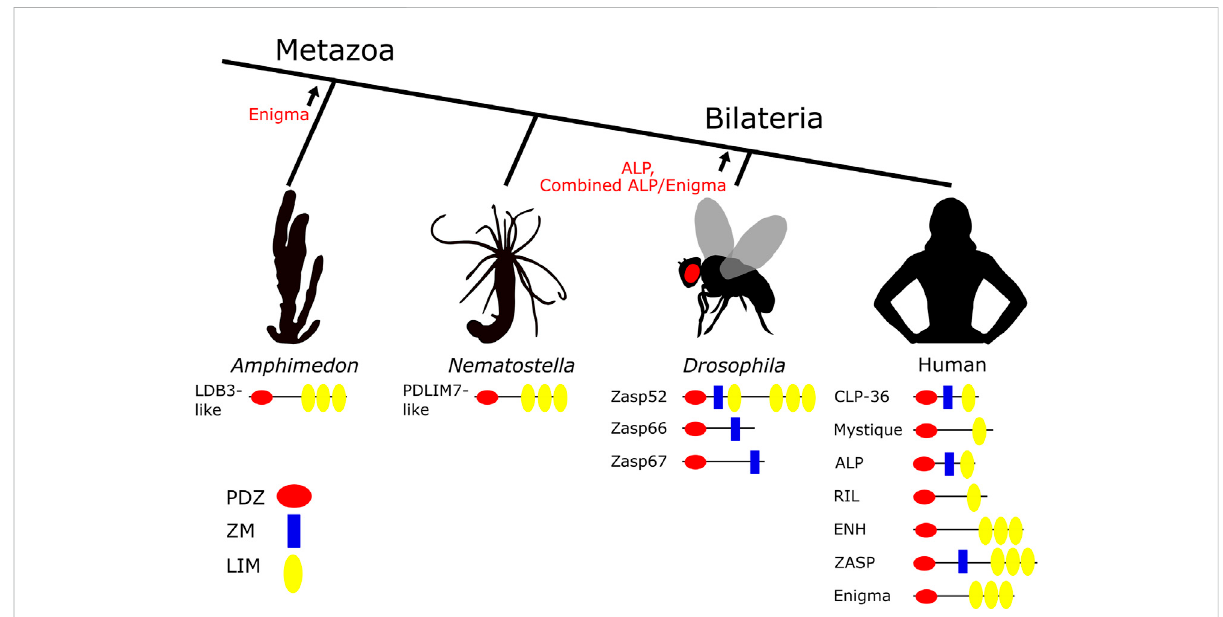
FIGURE 1 Origin and distribution of ALP/Enigma proteins in the metazoan tree. ALP/Enigma proteins fi rst evolved in metazoans as evidenced by single Enigma-like proteins found for example in the ancient phyla of Porifera (the sponge Amphimedon ) and Cnidaria (the sea anemone Nematostella ). In Bilateria, duplication and recombination gave rise to ALP-like proteins with a single, but different LIM domain, but also to combined ALP/Enigma proteins with four LIM domains (e.g. in Drosophila and C . elegans ), as well as proteins without LIM domains (Zasp66 and Zasp67 in Drosophila ). The ZM domain fi rst evolved in the ancestor of Bilateria. Evolutionary tree with representative species and the ALP/Enigma proteins with their